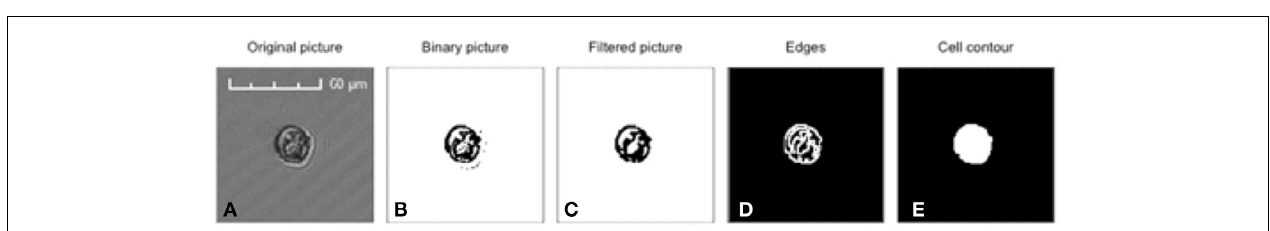
FIGURE 3 | Image processing of a Gymnodinium picture performed by the Fiji software in order to extract the cell dimensions. (A) Original picture (B) Binary transformed picture (C) Filtered binary picture (D) Edges detection between pixels (E) Contour selection of the cell.